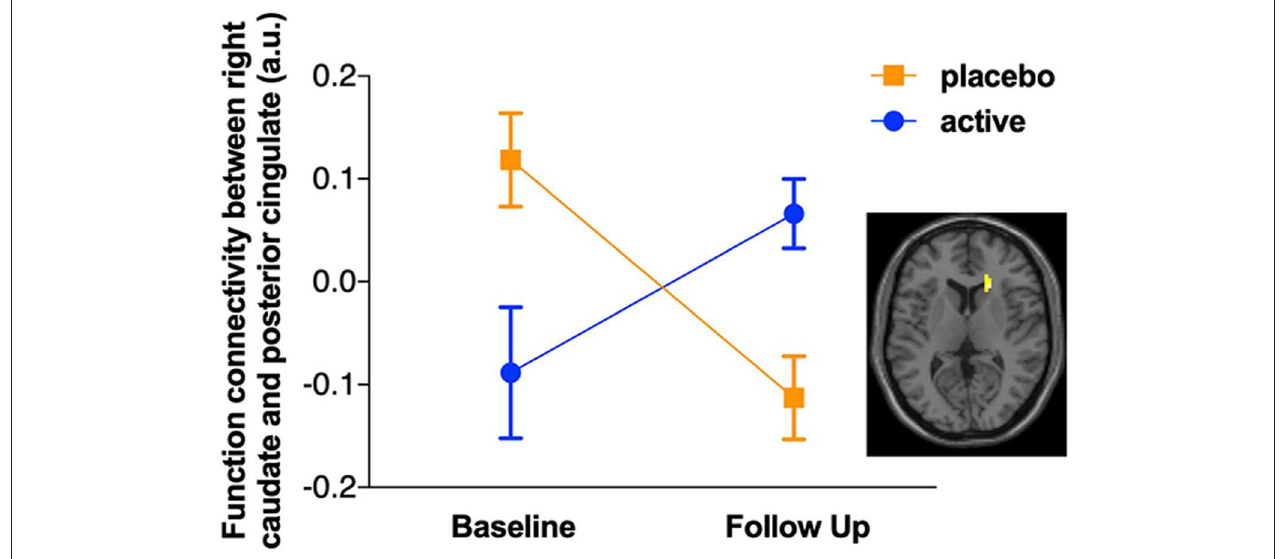
FIGURE 2 | Plot of the group × time interaction for functional connectivity between posterior cingulate cortex (PCC) seed and right caudate. After correcting for false discovery rate (FDR), a significant group × time interaction was observed for the functional connectivity between posterior cingulate cortex (PCC) seed and right caudate ( k = 60, p FDRcorrected = 0.046, t = 4.14 [21 24 9]). The post-hoc t -test suggested an increase of functional connectivity for the active group ( t = 2.06, p = 0.050), while there was a significant decrease for the placebo group ( t = − 3.52, p =